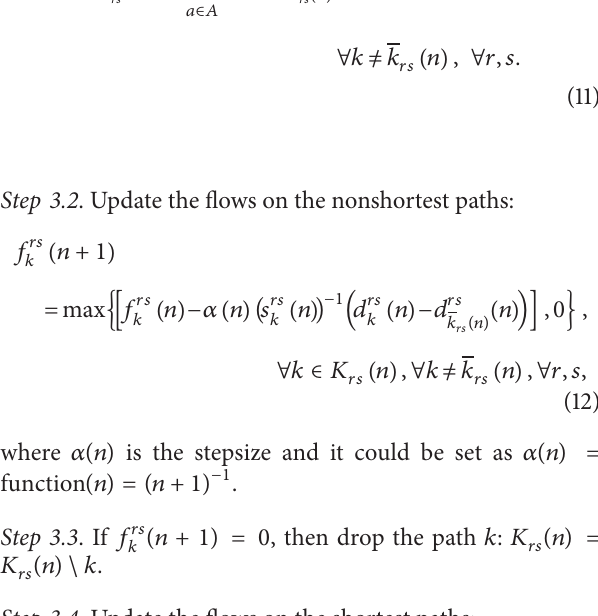
Table 2: Comparison of OD traveling